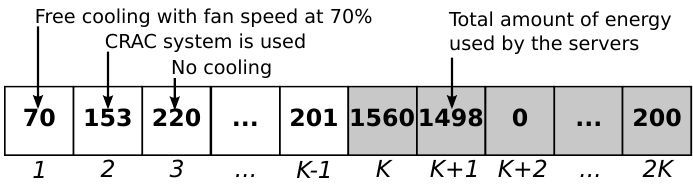
Figure 2. Representation of a sample